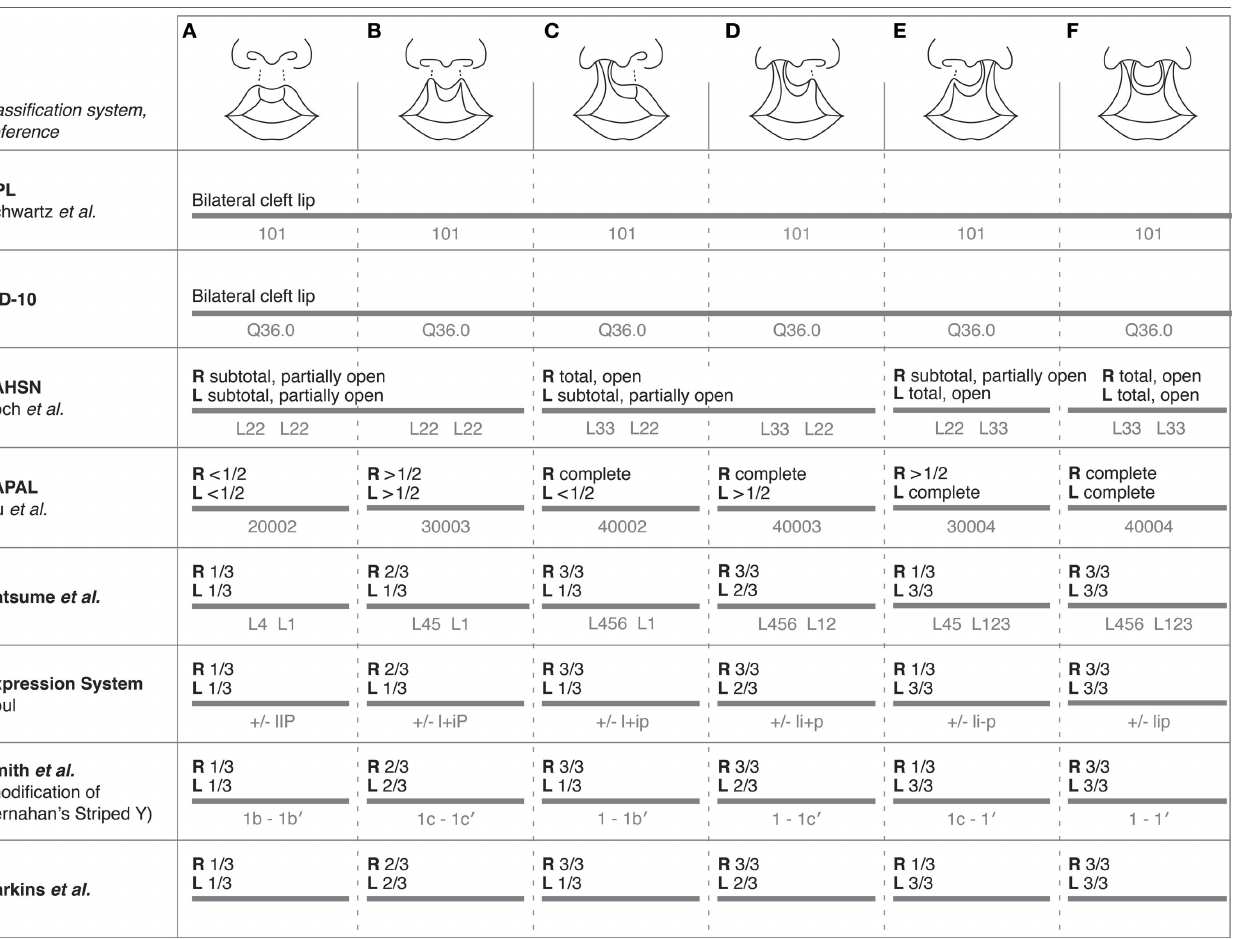
Table 3 | Comparisons among select systems for their ability to classify and code for characteristics of bilateral clefts of the lip with varying degrees of